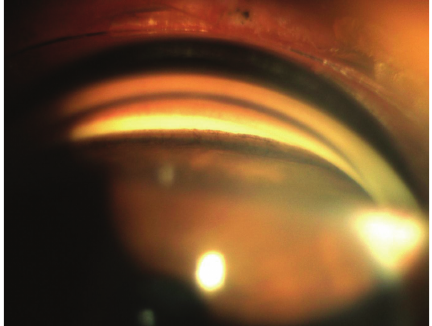
Figure 3: Gonioscopy of the right eye shows wide open and much pigmented chamber angle. The intense pigmentation on the external wall of the angle prevented the observation of other structures.